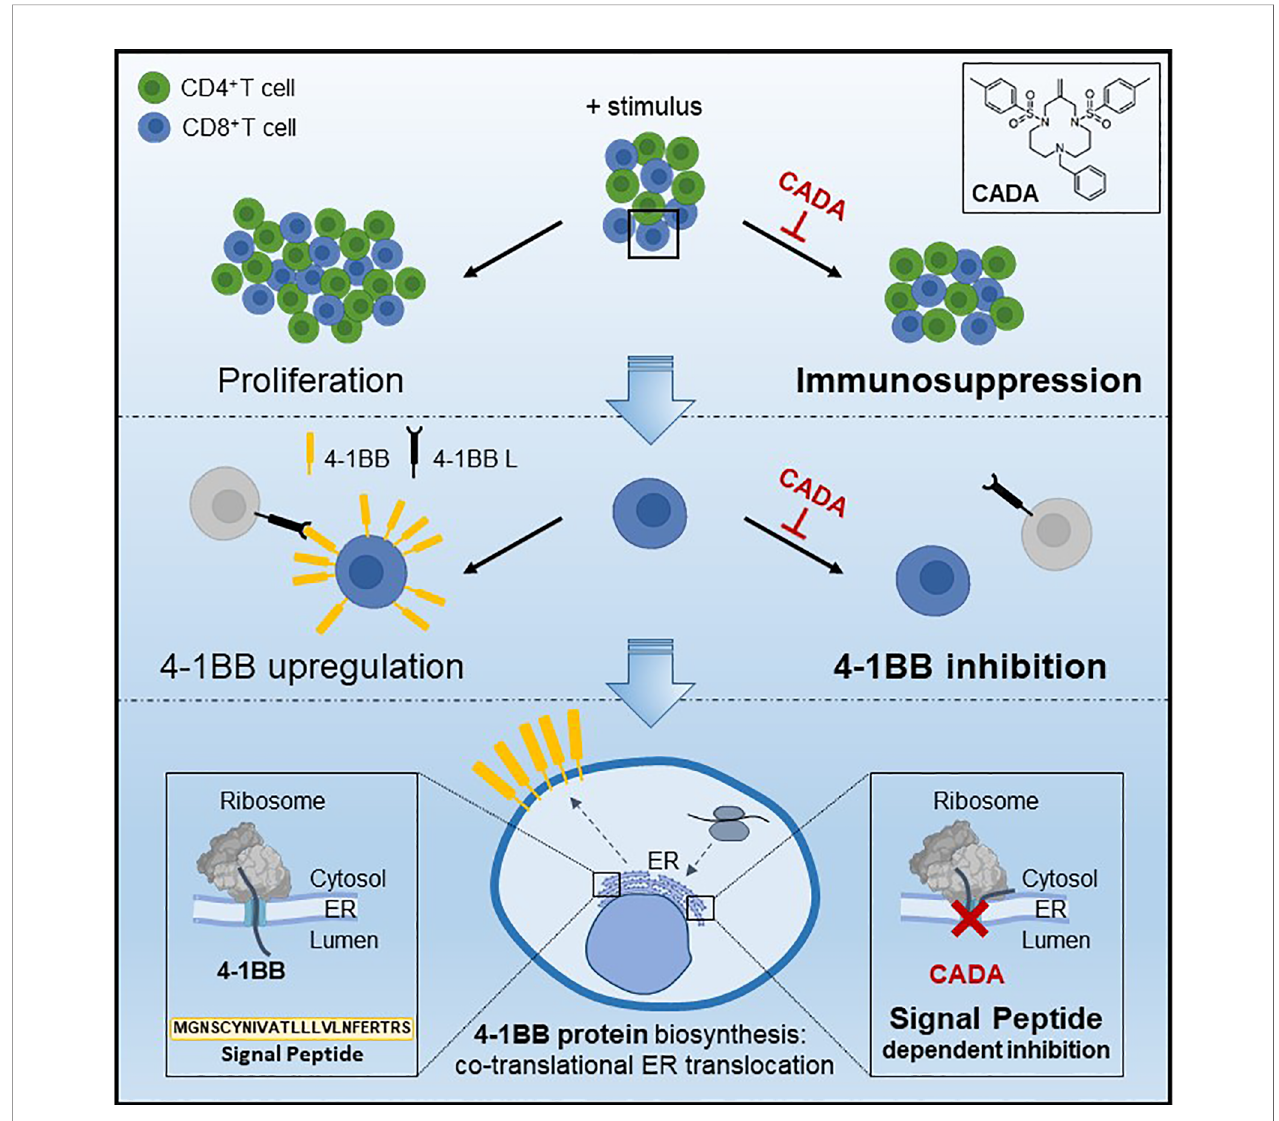
FIGURE 9 | Mode of action of CADA. CADA has immunosuppressive activity mainly on CD8 + T cells by inhibition of 4-1BB protein biogenesis is a signal peptide-dependent